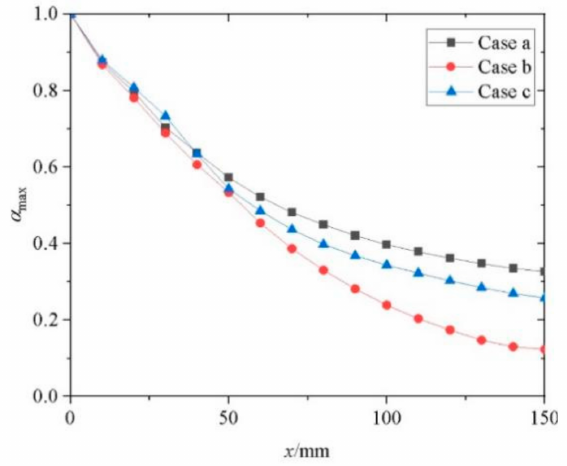
Figure 16. Maximum concentration decay curves for Case a, Case b, and Case